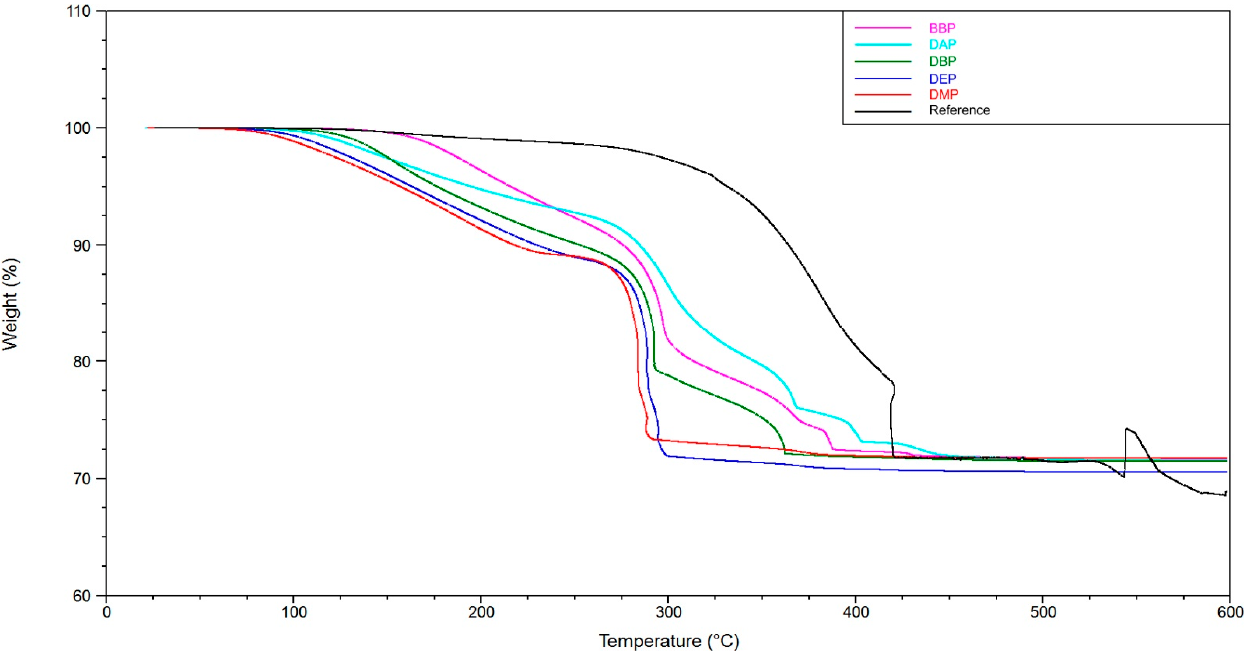
Figure 12. Thermo-gravimetric analysis of green bodies produced by LCM using suspensions with varying solvents .